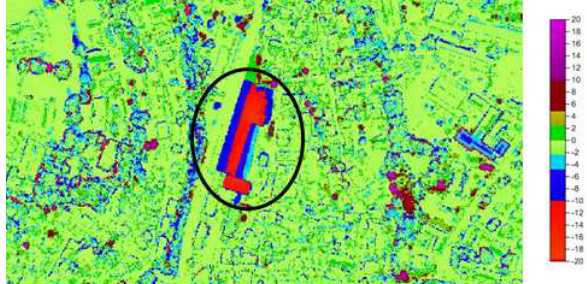
Figure 7. Differential DSM between Laserscanning and Image Matching – new buildings are painted in red and areas under construction in violet